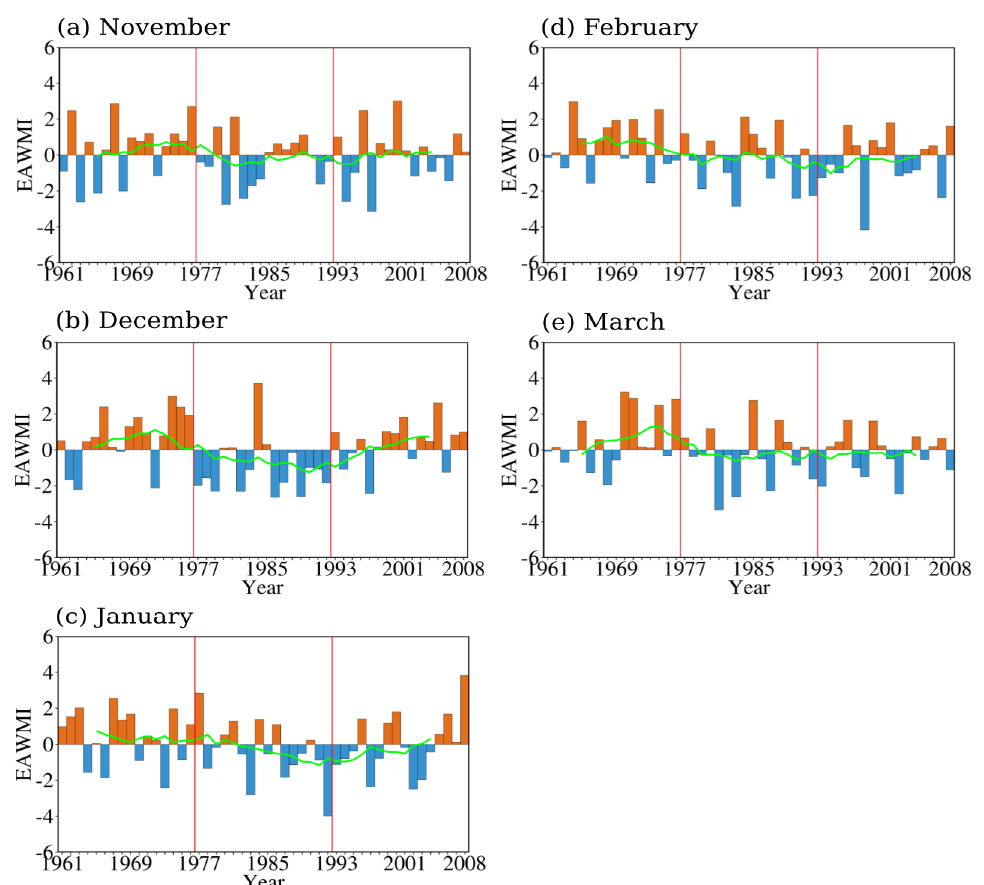
Figure 14. Time series of the East Asian winter monsoon index (EAWMI) (see text for details for the derivation of the index) from 1961 to 2008 for ( a ) November; ( b ) December; ( c ) January; ( d ) February; and ( e ) March. The red vertical lines indicate the change points around 1976/1977 and 1992/1993 based on the December rainfall time series for reference discussion. The green line indicates the 9-yr running average.